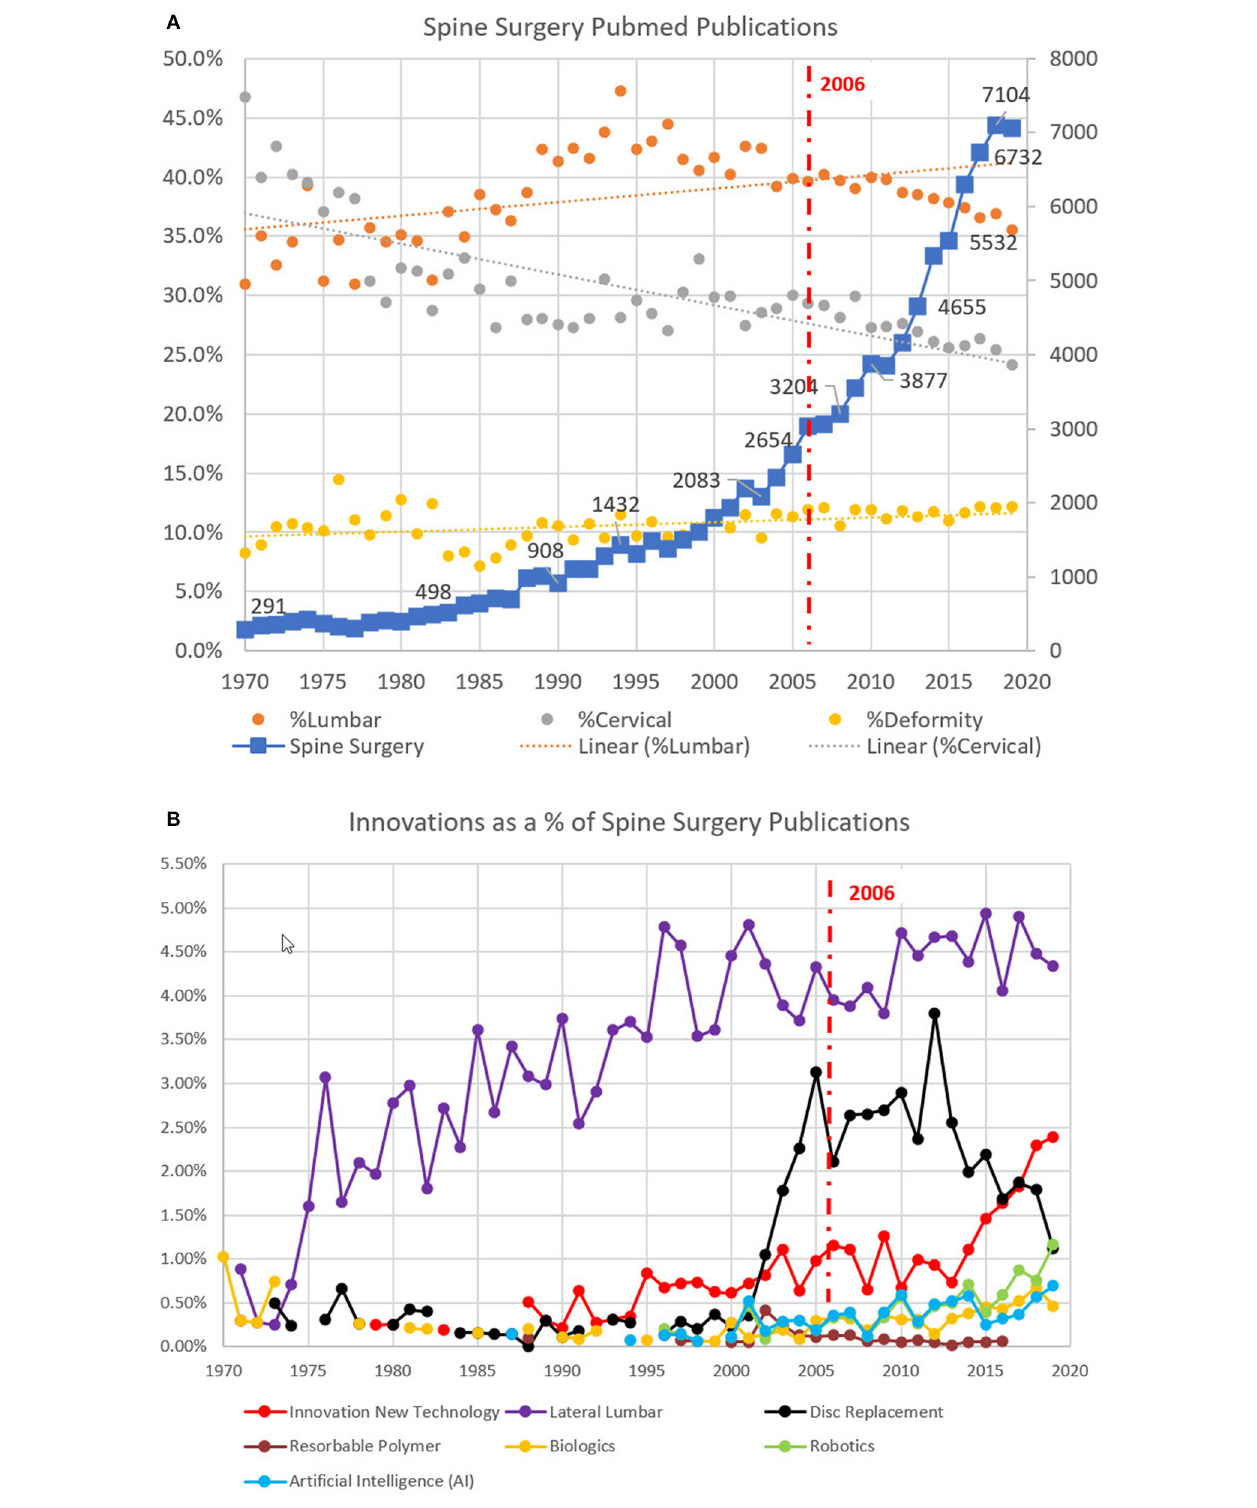
FIGURE 1 | (A) Pubmed keyword search for the time (1970–2019) including keywords: spine surgery AND lumbar, cervical, and deformity. (B) Pubmed keyword search for the same period (1970–2019) including keywords: lateral lumbar, disc replacement, and resorbable polymer AND spine surgery.